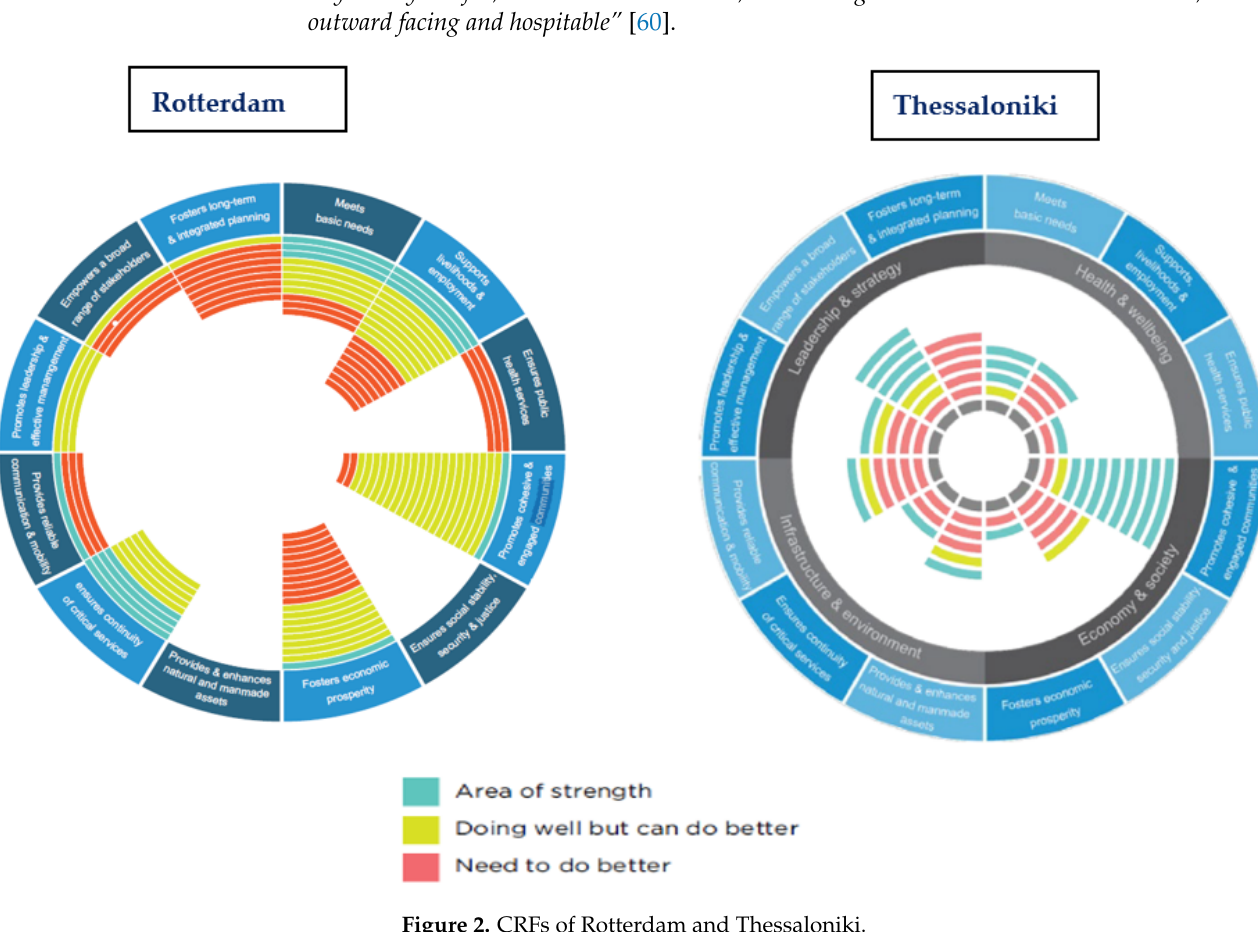
Figure 2. CRFs of Rotterdam and Thessaloniki .